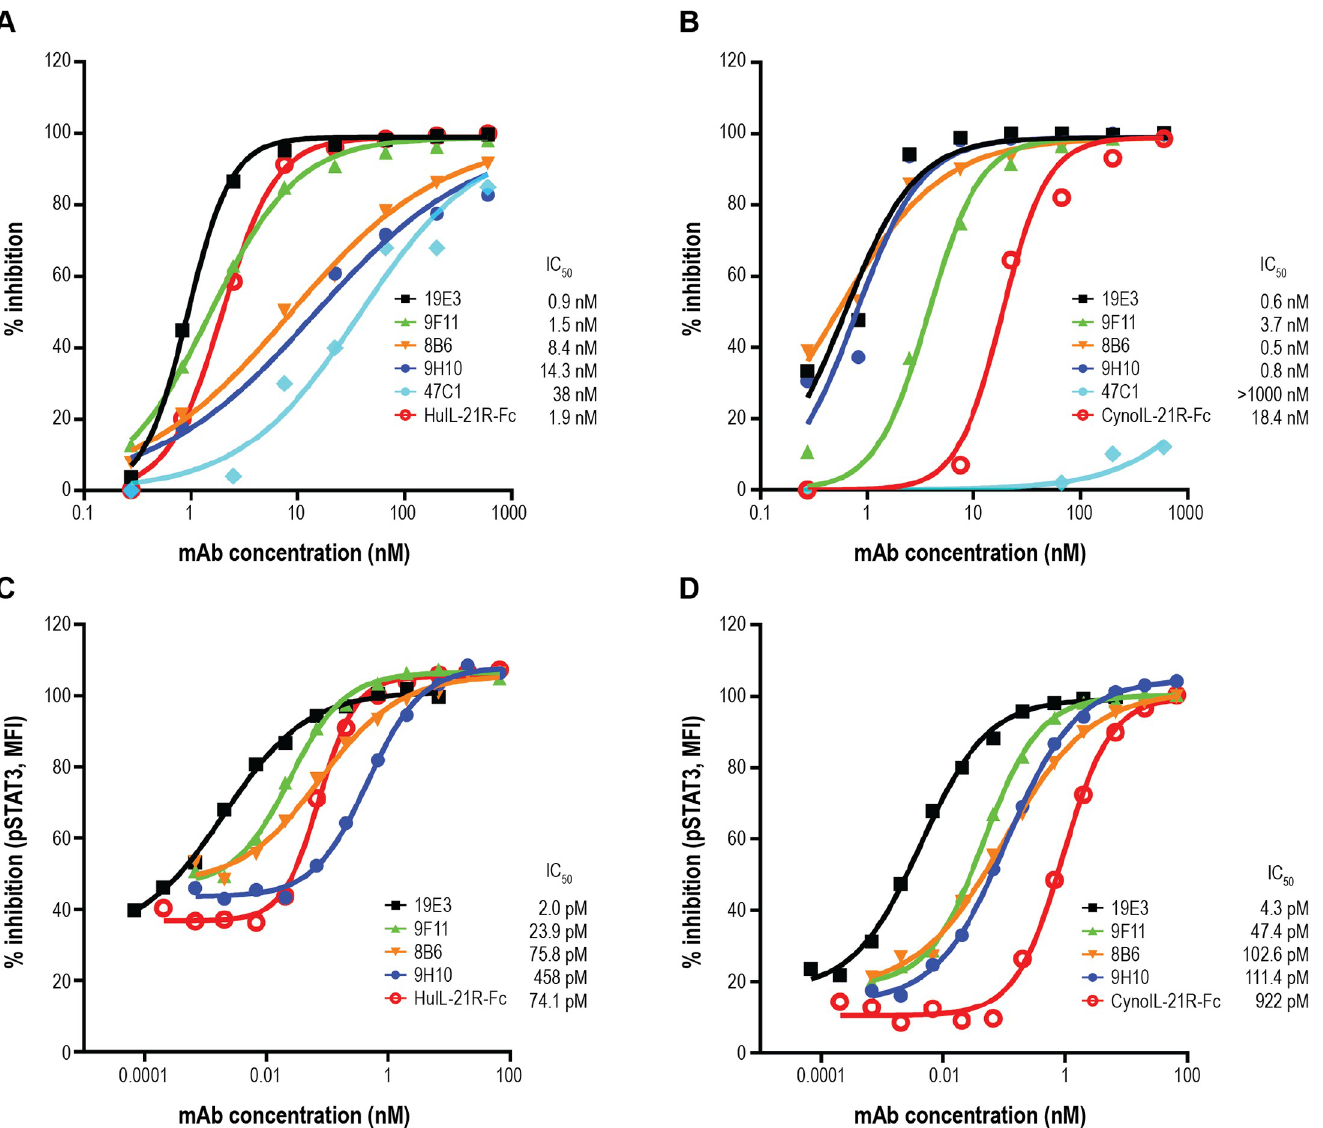
Fig 3. Lead hybridoma clones blocked receptor engagement and inhibited signaling through IL-21R. The 5 most potent inhibitory hybridoma clones were purified and re-tested in the inhibition assay against (A) human IL-21/IL-21R-Fc and (B) cyno IL-21/IL-21R-Fc interactions. Human PBMCs were stimulated for 15 min with (C) human or (D) cyno IL-21, and phosphorylation of STAT3 was quantified by flow cytometry. Graphs represent inhibition of IL-21–induced STAT3 phosphorylation by the indicated hybridoma clones. Data are representative of 3 donors tested. Percent inhibition was calculated as: 100 � (1-(pSTAT3 MFI of stimulated+MEDI7169—pSTAT3 MFI of unstimulated)/(pSTAT3 MFI of stimulated—pSTAT3 MFI from unstimulated)).